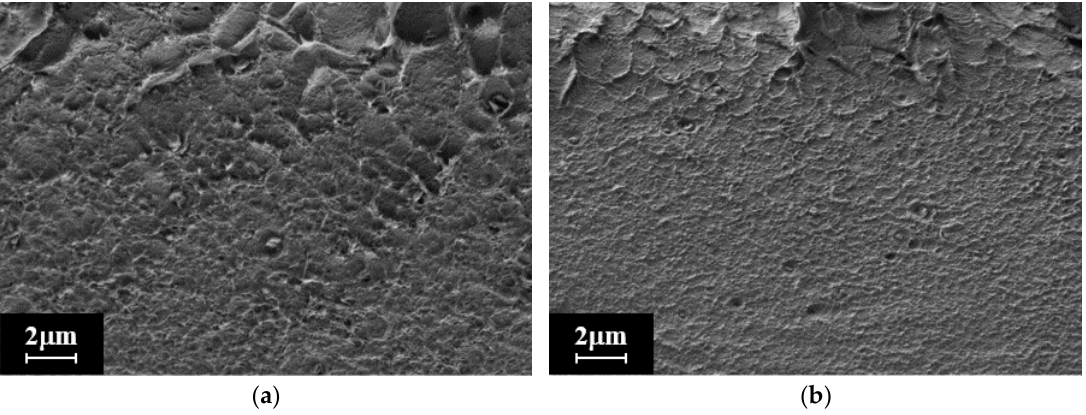
Figure 4. SEM images of film cross-sections: ( a ) PHI and ( b ) PHI- Сu(I).